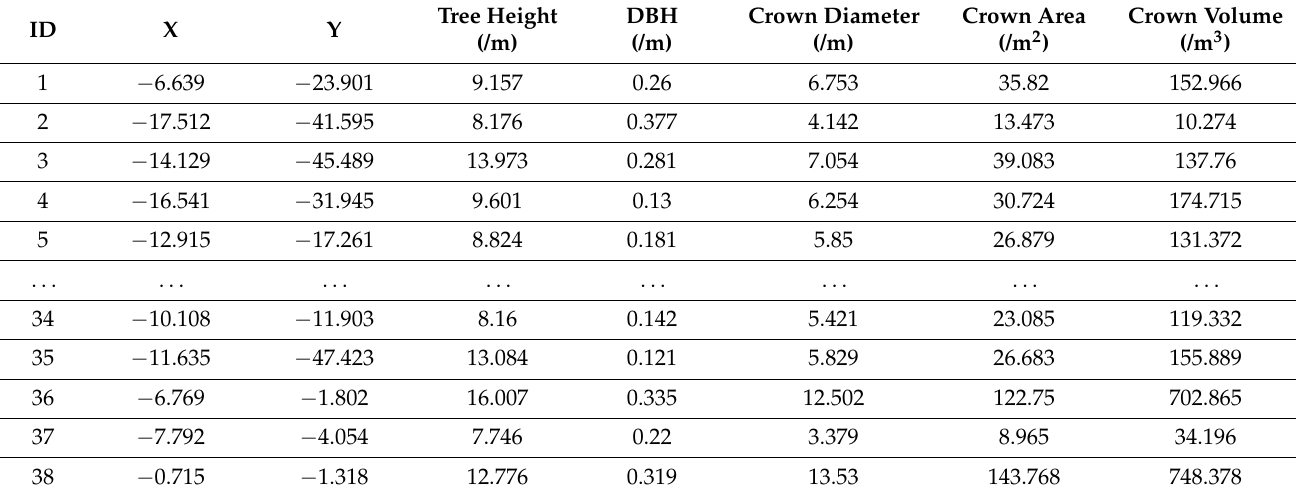
Table 1. Different parameters of single tree extraction.